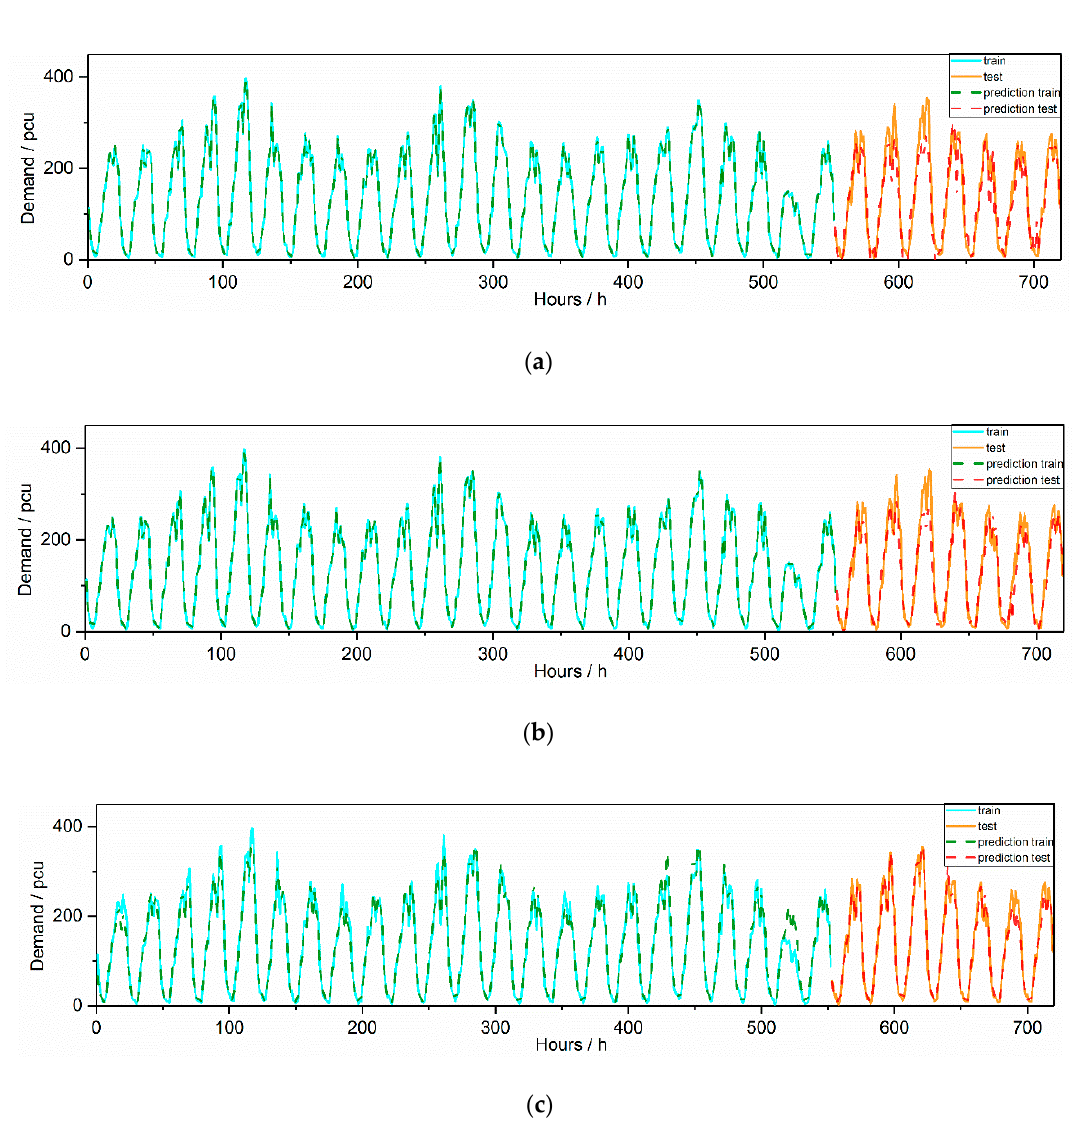
Figure 6. Online taxi-hailing demand prediction results of models based on extreme gradient boosting (XGB). ( a ) Result of model “BPNN + T”; ( b ) Result of model “BPNN + T + E”; ( c ) Result of model “BPNN + T + E + TX”.